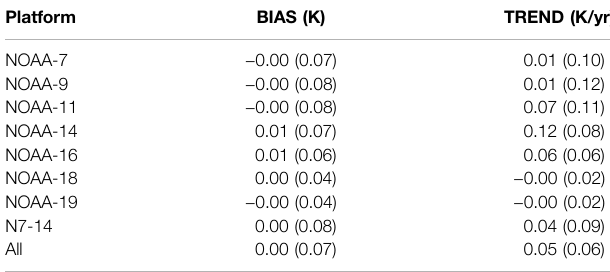
TABLE 4 | Statistical assessment of our orbital drift correction method in the ideal case for each NOAA platform, for NOAA-7 to 14 platforms, and overall: average value over all sites with its standard deviation in parentheses. TREND: the lineal trend of the difference between drifted and reference time series. Platform